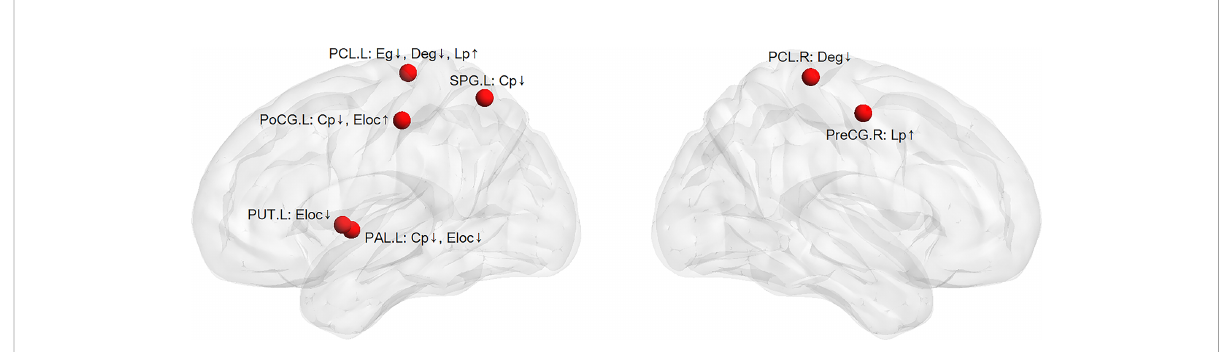
FIGURE 3 The weakened nodal network metrics in the DPN group compared with the non-DPN group and healthy control group. (PreCG, precentral gyrus; PoCG, postcentral gyrus; SPG, superior parietal gyrus; PCL, paracentral lobule; PUT, putamen; PAL, globus pallidum; Eloc, local ef fi ciency; Cp, cluster coef fi cient; Eg, global ef fi ciency; Lp, shortest path length; ↑ or ↓ : the values of nodal network metrics in the DPN group are greater/ smaller than those in the non-DPN group and the healthy control